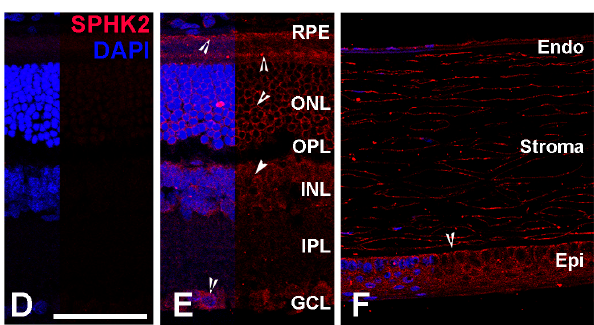
Figure 3. Localization of SPHK1 and SPHK2 in adult (2–7 months old) rat ocular tissues. SPHK1 and SPHK2 localization was detected by anti-SPHK1 (green) and anti-SPHK2 (red) antibodies. ( A ) Rat retinal section in which the anti-SPHK1 antibodies were replaced with normal rabbit serum. The layers were marked and served as a negative control. ( B ) Retinal section of SD rat eye and SPHK1 localization in different layers is shown by arrowheads. ( C ) Corneal section of SD rat eye and SPHK1 localization in different layers is shown by arrowheads. ( D ) Rat retinal section in which the anti-SPHK2 antibodies were replaced with normal rabbit serum. The layers were marked and served as a negative control. ( E ) Retinal section of SD rat eye and SPHK2 localization in different layers is shown by arrowheads. ( F ) Corneal section of SD rat eye and SPHK2 localization in different layers is shown by arrowheads. CB, ciliary body. RPE, retinal pigment epithelium. PR, photoreceptor. ONL, outer nuclear layer. OPL, outer plexiform layer. INL, inner nuclear layer. IPL, inner plexiform layer. GCL, ganglion cell layer. Endo, endothelium. Epi, epithelium. Scale = 50 µm.